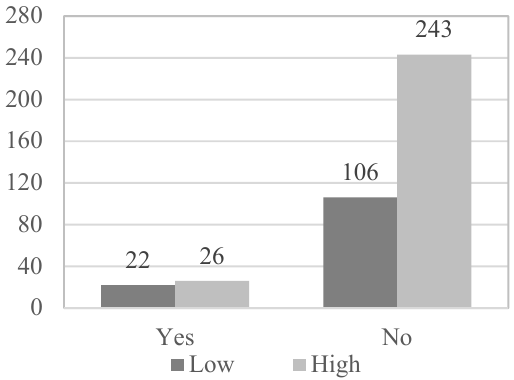
Figure 2. Psychological problem_Health satisfaction.